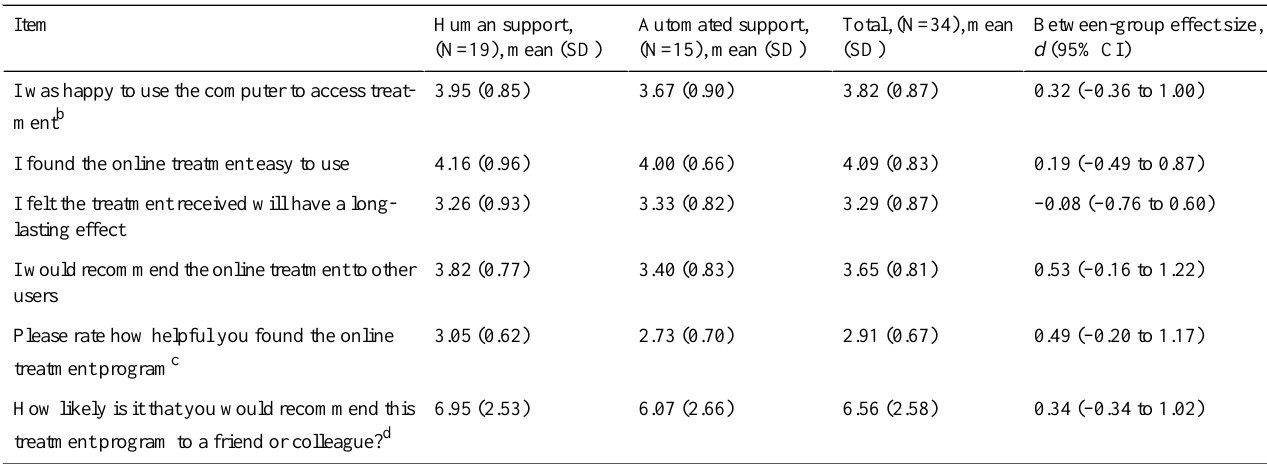
Table 5. Descriptive statistics for the SAT a .